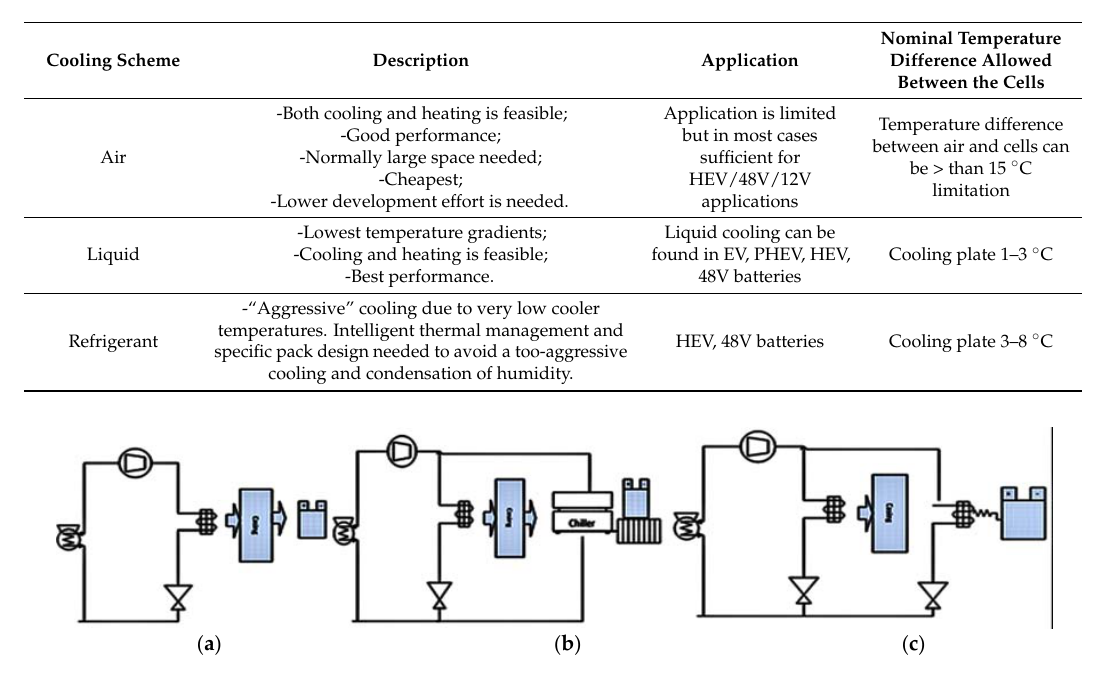
Table 1. Comparison between different cooling schemes in traditional BTMSs [66]. HEV: Hybrid electric vehicle; and PHEV: Plug-in Hybrid Electric Vehicles.